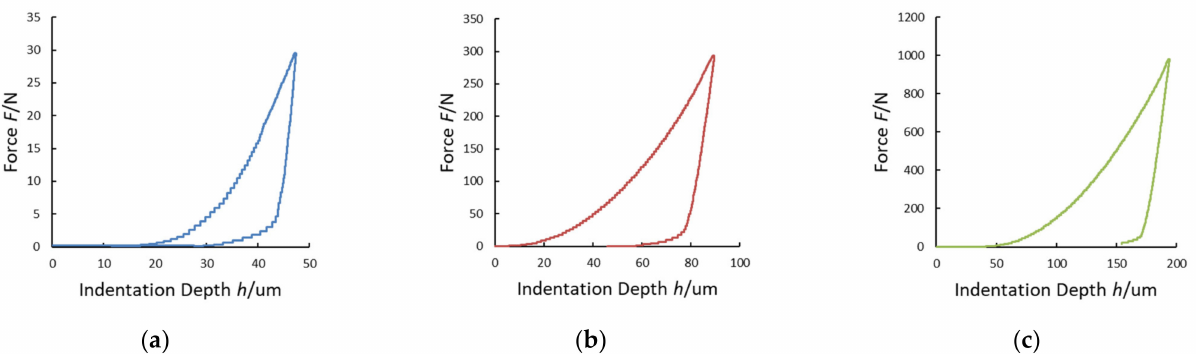
Figure 7. Loading–unloading curves of the Vickers hardness (HV) tests on stainless steel: ( a ) HV3; ( b ) HV30; ( c ) HV100.